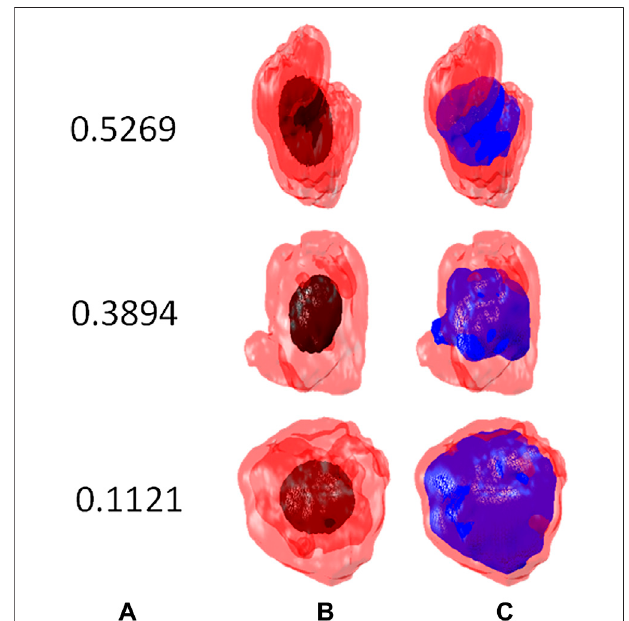
FIGURE 3 | Principal component analysis of the tumor interface. (A) fractional anisotropy of the ellipsoid obtained by PCA, (B) PCA ellipsoids, (black), located inside the tumor interface (red) and (C) tumor interface correction